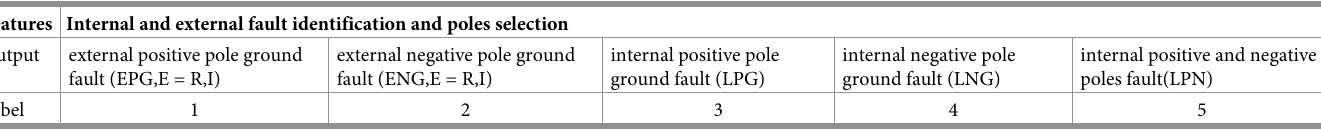
Table 1. Random forests classification